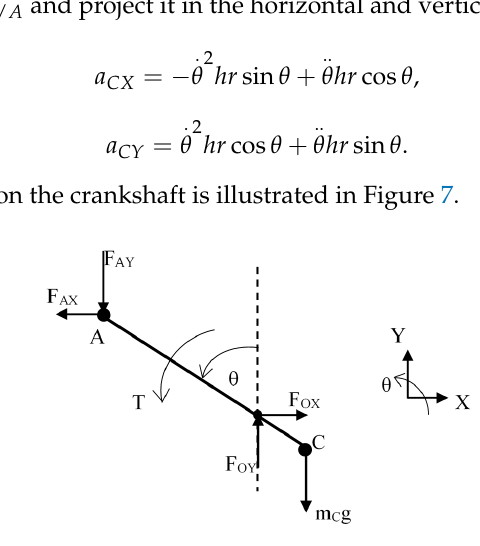
Figure 7. The forces acting on the crankshaft.